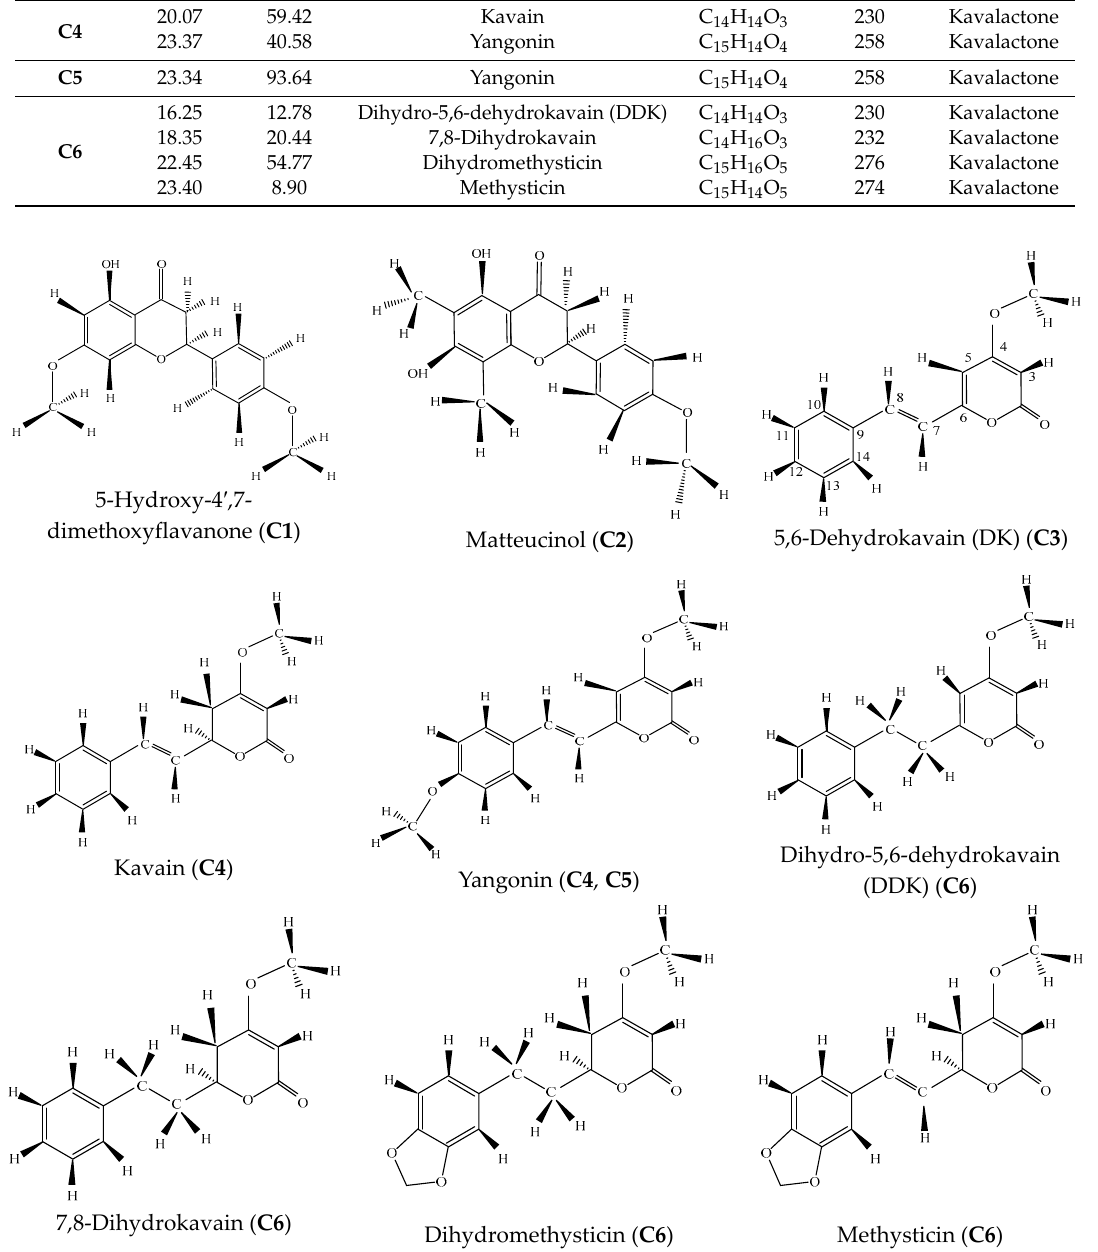
Figure 1. Chemical structures of bioactive constituents from P. methysticum root. Table 4. Identification of bioactive compounds from EtOAc extract of P. methysticum root by GC-MS, ESI-MS and 1 H- and 13 C-NMR.